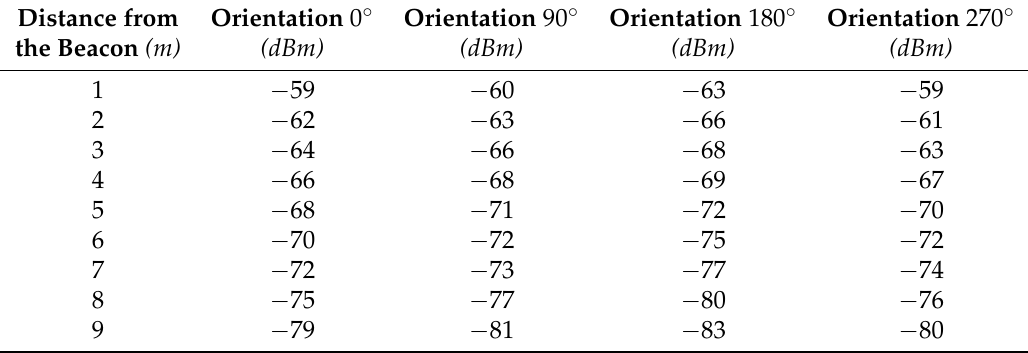
Table 3. Analysis of BLE beacon’s RSS variations with the influence of different holding orientations of the mobile